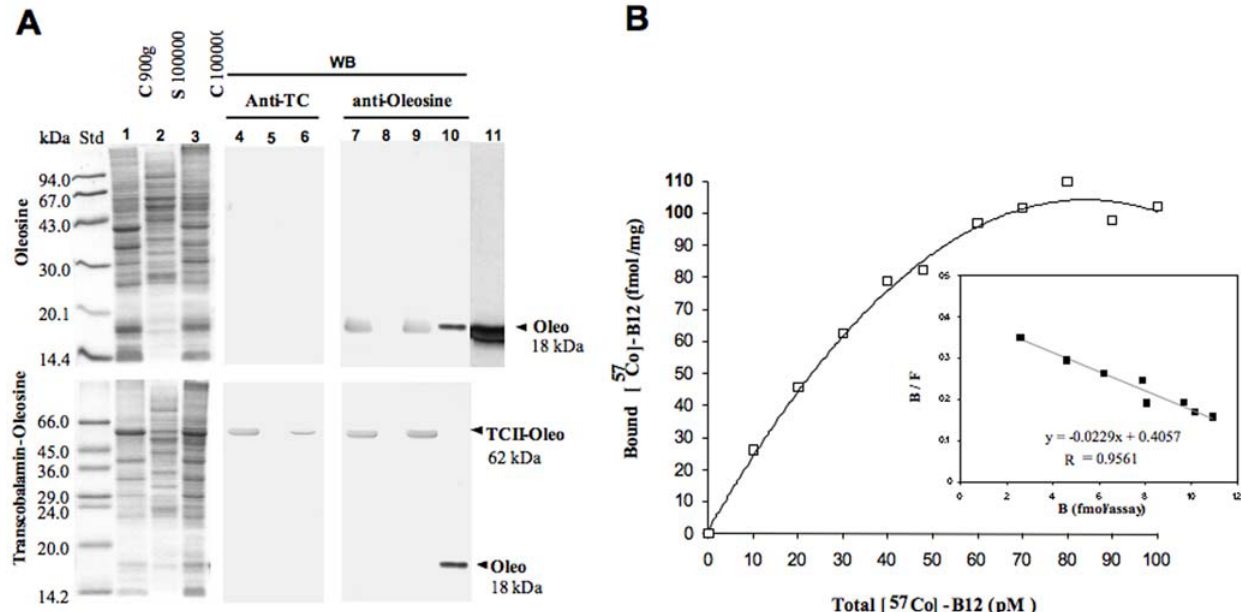
Figure 2. (A) Characterization of the recombinant oleosin (top) and transcobalamin-oleosin (bottom) chimeric proteins; SDS-PAGE (12.5%) (lanes 1– 3, 10) and Western blot (WB) (lanes 4–9) of subcellular fractions (pellets and supernatant from differential centrifugation) from Sf 9 cells infected with recombinant baculovirus expressing either peanut oleosin or the transcobalamin-oleosin chimeric protein. Lanes 1, 4, 7: 900 g pellet, lanes 2, 5, 8: 100 000 g supernatant, lanes 3, 6, 9: 100 000 g pellet, lane 10: 85 ng purified peanut oleosin and lane 11: autoradiography of [ 14 C]-leucine-labeled oleosin expressed in rabbit reticulocyte lysate. (B) Saturation curve of vitamin B12 binding of transcobalamin-oleosin (TC-O) in membrane fraction of lysed sf9 insect cells and corresponding Scatchard plot